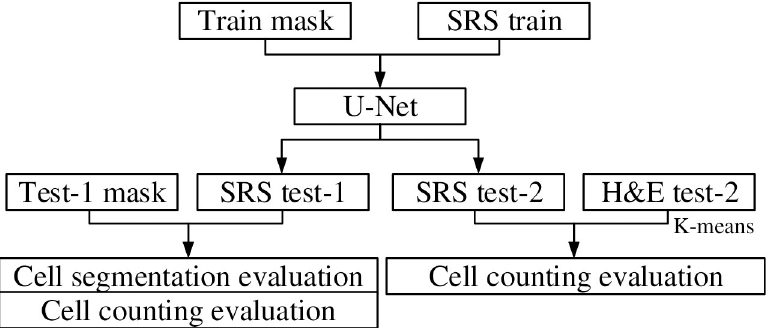
Fig 5. Cell counting framework. Cell counting framework. Train mask: manually generated cell annotation mask image for the training region; SRS train: the SRS image of the training region; Test-1 mask: manually generated cell annotation mask image for the first testing region; SRS test-1 and SRS test-2: the SRS images of the first and second testing regions; H&E test-2: the H&E image of the second testing region.